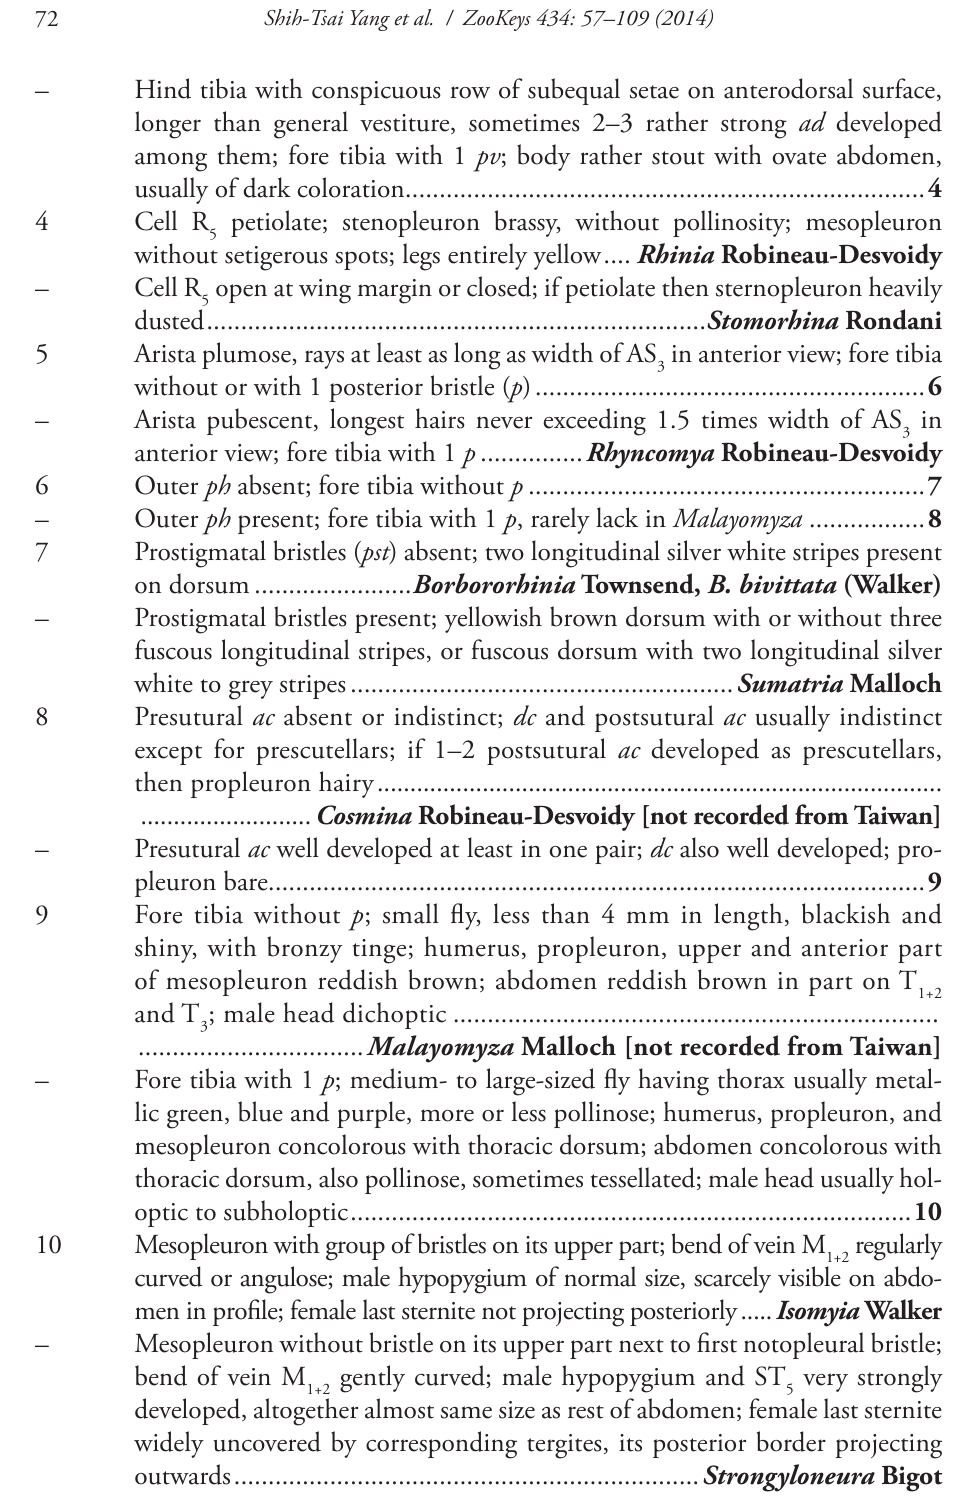
– Hind tibia with conspicuous row of subequal setae on anterodorsal surface, longer than general vestiture, sometimes 2–3 rather strong ad developed among them; fore tibia with 1 pv ; body rather stout with ovate abdomen, usually of dark coloration ............................................................................ 4 4 Cell R petiolate; stenopleuron brassy, without pollinosity; mesopleuron 5 without setigerous spots; legs entirely yellow .... Rhinia Robineau-Desvoidy – Cell R open at wing margin or closed; if petiolate then sternopleuron heavily 5 5 Arista plumose, rays at least as long as width of AS in anterior view; fore tibia 3 without or with 1 posterior bristle ( p ) ......................................................... 6 – Arista pubescent, longest hairs never exceeding 1.5 times width of AS in 3 anterior view; fore tibia with 1 p ............... Rhyncomya Robineau-Desvoidy 6 Outer ph absent; fore tibia without p .......................................................... 7 – Outer ph present; fore tibia with 1 p , rarely lack in Malayomyza ................. 8 7 Prostigmatal bristles ( pst ) absent; two longitudinal silver white stripes present on dorsum ....................... Borbororhinia Townsend, B. bivittata (Walker) – Prostigmatal bristles present; yellowish brown dorsum with or without three fuscous longitudinal stripes, or fuscous dorsum with two longitudinal silver white to grey stripes ........................................................ Sumatria Malloch 8 Presutural ac absent or indistinct; dc and postsutural ac usually indistinct except for prescutellars; if 1–2 postsutural ac developed as prescutellars, then propleuron hairy ...................................................................................... – Presutural ac well developed at least in one pair; dc also well developed; pro- 9 Fore tibia without p ; small fly, less than 4 mm in length, blackish and shiny, with bronzy tinge; humerus, propleuron, upper and anterior part of mesopleuron reddish brown; abdomen reddish brown in part on T 1+2 and T ; male head dichoptic ....................................................................... 3 – Fore tibia with 1 p ; medium- to large-sized fly having thorax usually metal- lic green, blue and purple, more or less pollinose; humerus, propleuron, and mesopleuron concolorous with thoracic dorsum; abdomen concolorous with thoracic dorsum, also pollinose, sometimes tessellated; male head usually hol- optic to subholoptic .................................................................................. 10 10 Mesopleuron with group of bristles on its upper part; bend of vein M regularly 1+2 curved or angulose; male hypopygium of normal size, scarcely visible on abdo- men in profile; female last sternite not projecting posteriorly ..... Isomyia Walker – Mesopleuron without bristle on its upper part next to first notopleural bristle; bend of vein M gently curved; male hypopygium and ST very strongly 1+2 5 developed, altogether almost same size as rest of abdomen; female last sternite widely uncovered by corresponding tergites, its posterior border